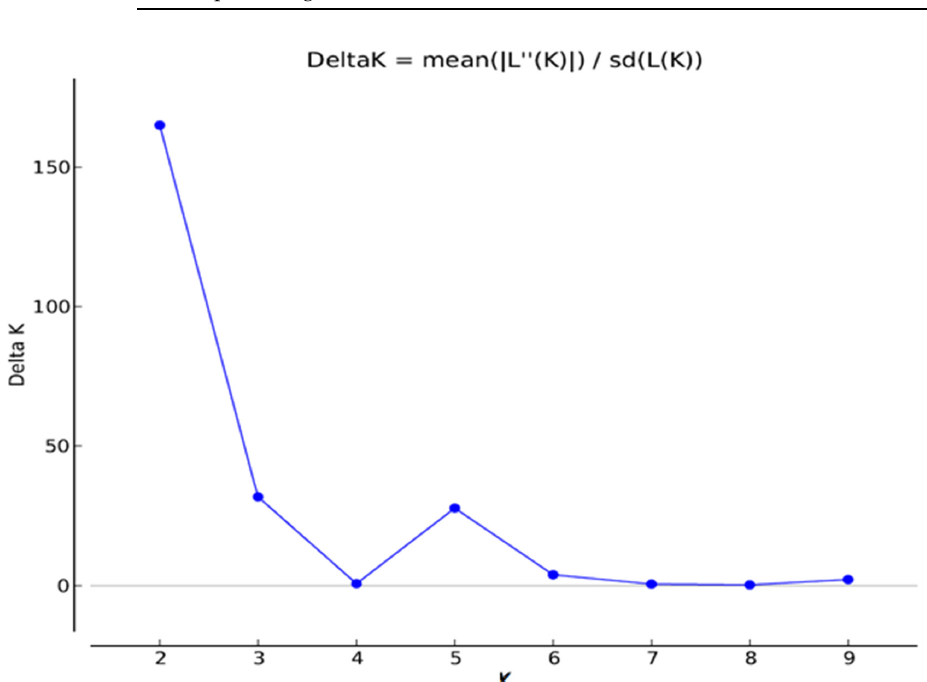
Figure 2. Plot of Δ K (filled circles, solid line) calculated as the mean of the second-order rate of change in likelihood of K divided by the standard deviation of the likelihood of K, m(|L ″ (K)|/s[L(K)].